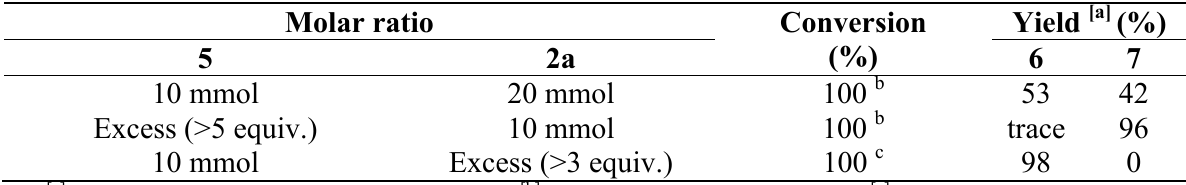
Table 4. The Claisen-Schmidt reaction of acetone ( 5 ) with benzaldehyde ( 2a ) in presence of 20 mol% of solid NaOH by grinding in a mortar and pestle of 5